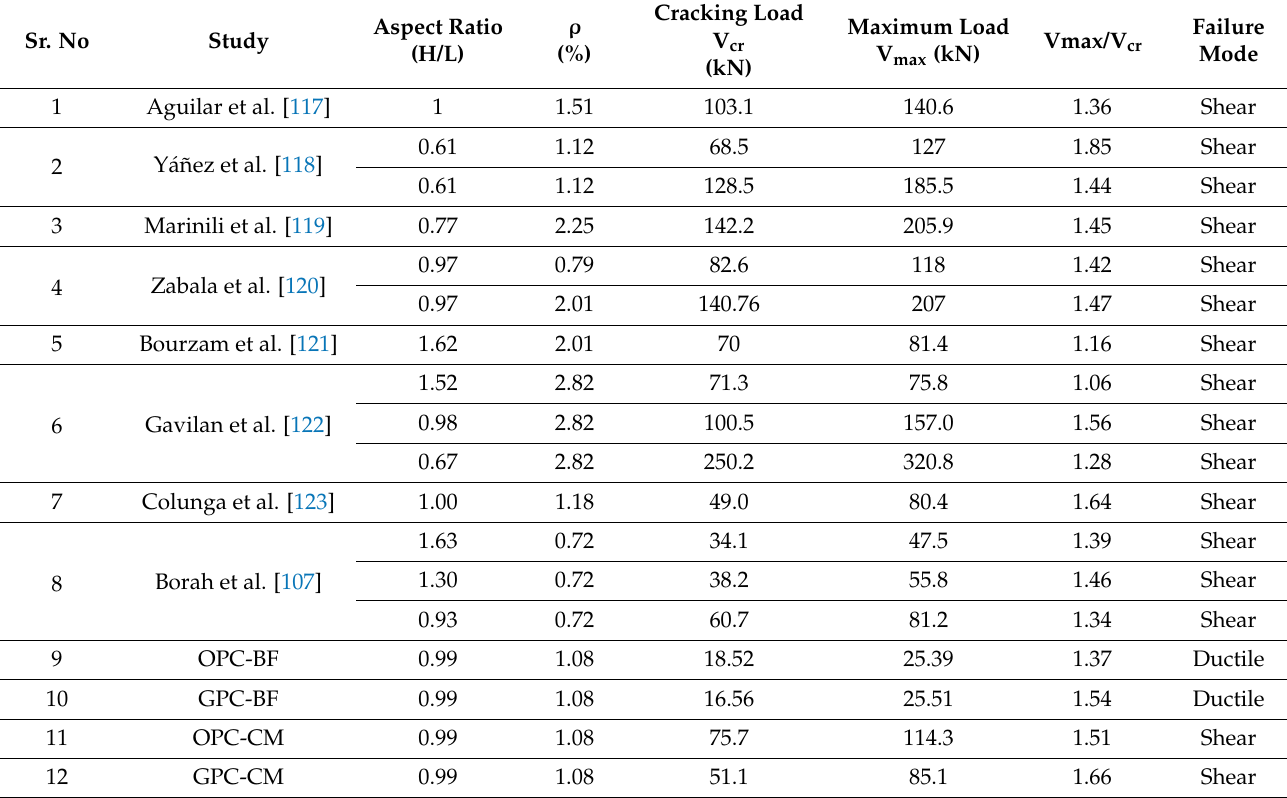
Table 6. Comparison of the present study with past studies on confined